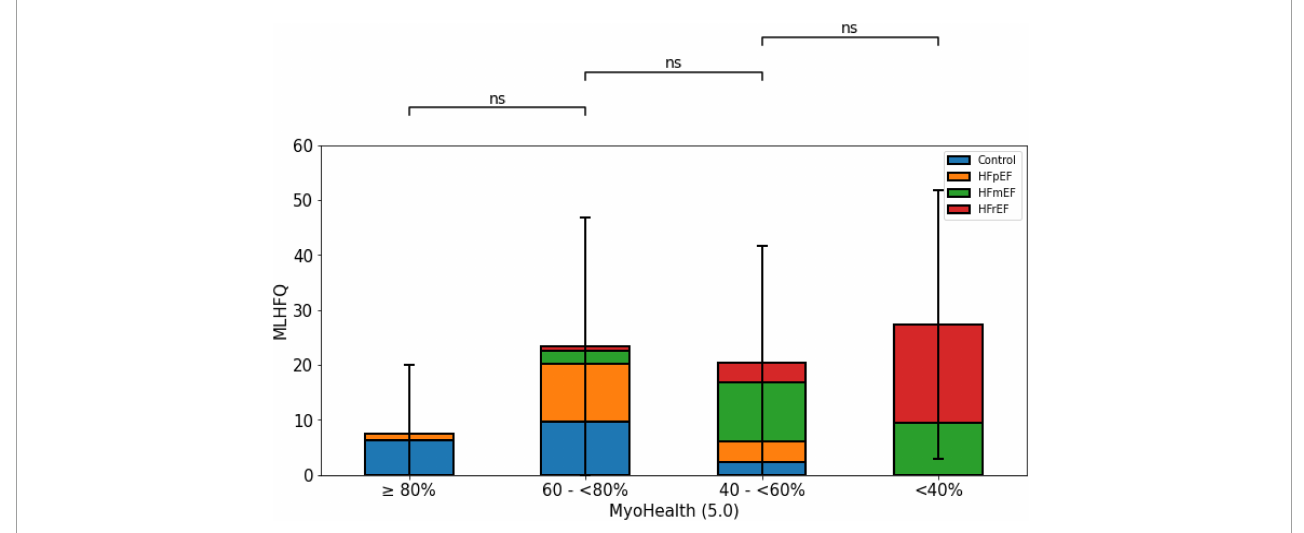
FIGURE3 Quality of life by MLHFQ across MyoHealth groups. MyoHealth ≥ 80% vs. MyoHealth 60– < 80%: p = 0.15; MyoHealth 60– < 80% vs. MyoHealth 40– < 60%: p = 1; MyoHealth 40– < 60% vs. MyoHealth < 40%: p = 1. ns, not significant.